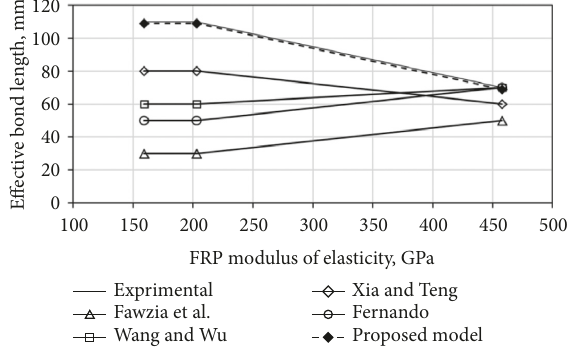
Figure 6: Effective bond length vs. FRP modulus, comparing results from tests and FE models corresponding to existing τ –s models.